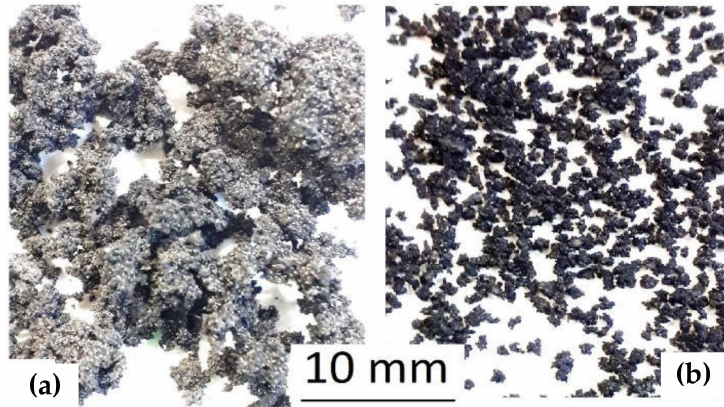
Figure 13. Pure rubber particles before ( a ) and after ( b ) grinding by disintegrator mills.